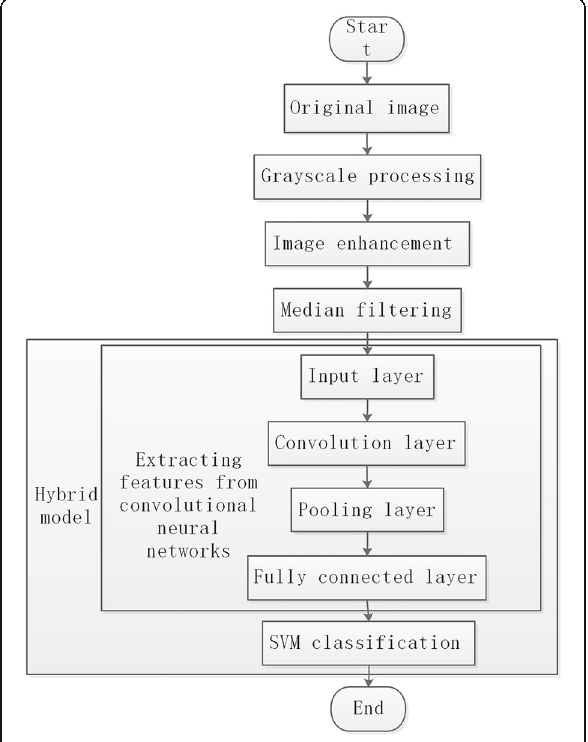
Fig. 1 Image classification process of ice